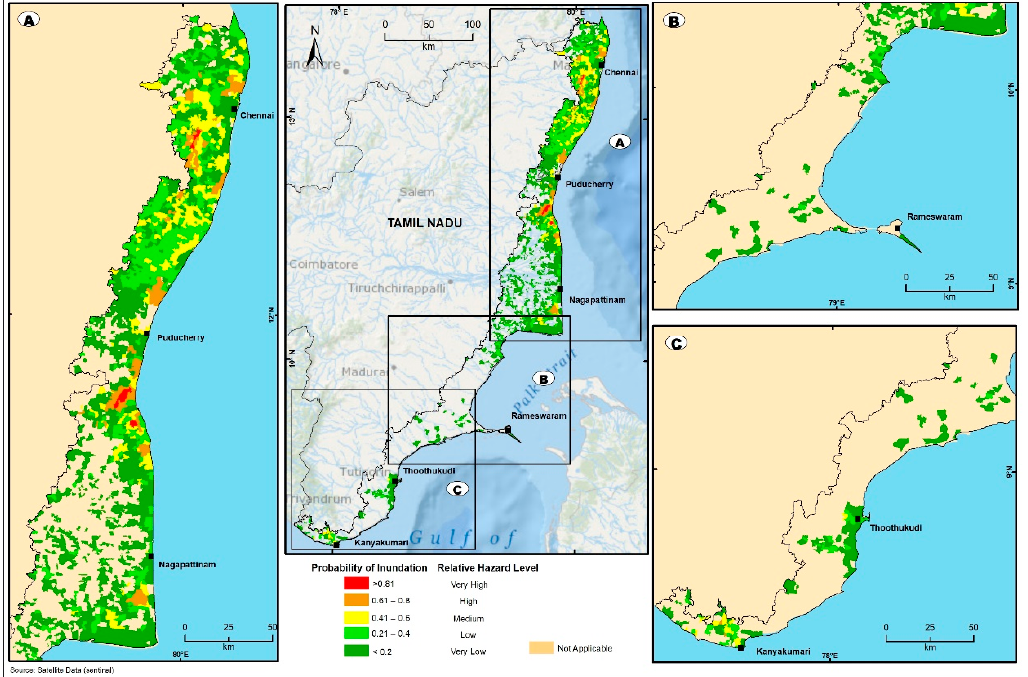
Figure 4. Flood hazard in the coastal plains of Tamil Nadu. The level of flood hazard in the northern, central, and southern parts of the study area are represented in inset figures A,B and C, respectively.